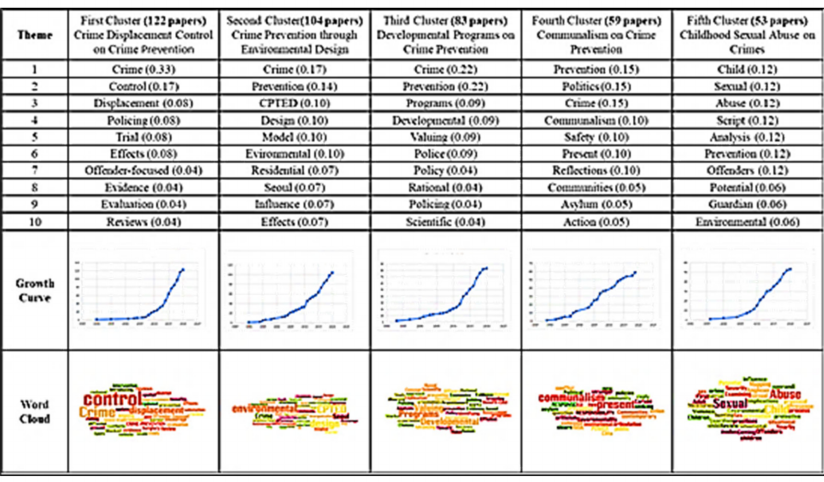
Figure 5. Top 5 clusters of crime prevention-related academic literature.